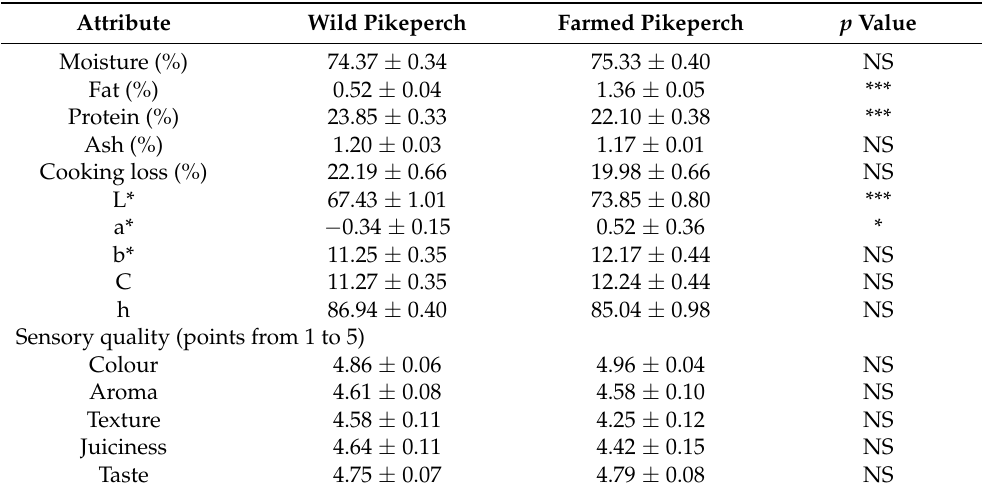
Table 5. The influence of life environment on the composition and colour of sous-vide (65 ◦ C, 40 min) pikeperch fillets (mean values ± standard